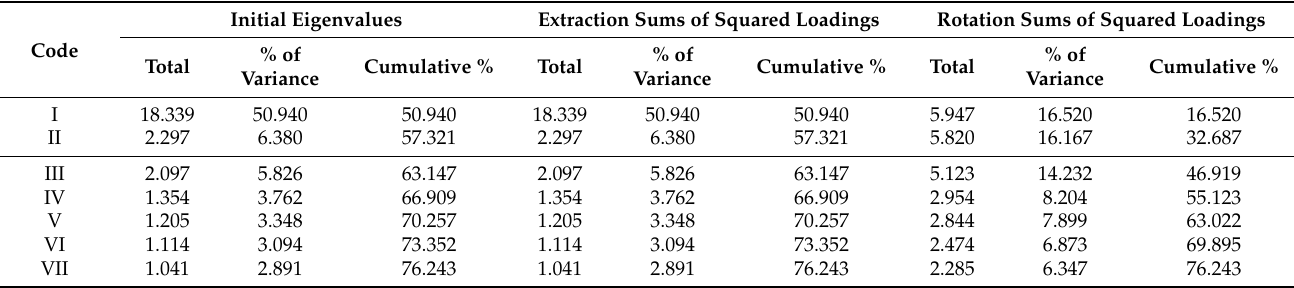
Table 8. Total variance explained for CSFs in the ULS projects.